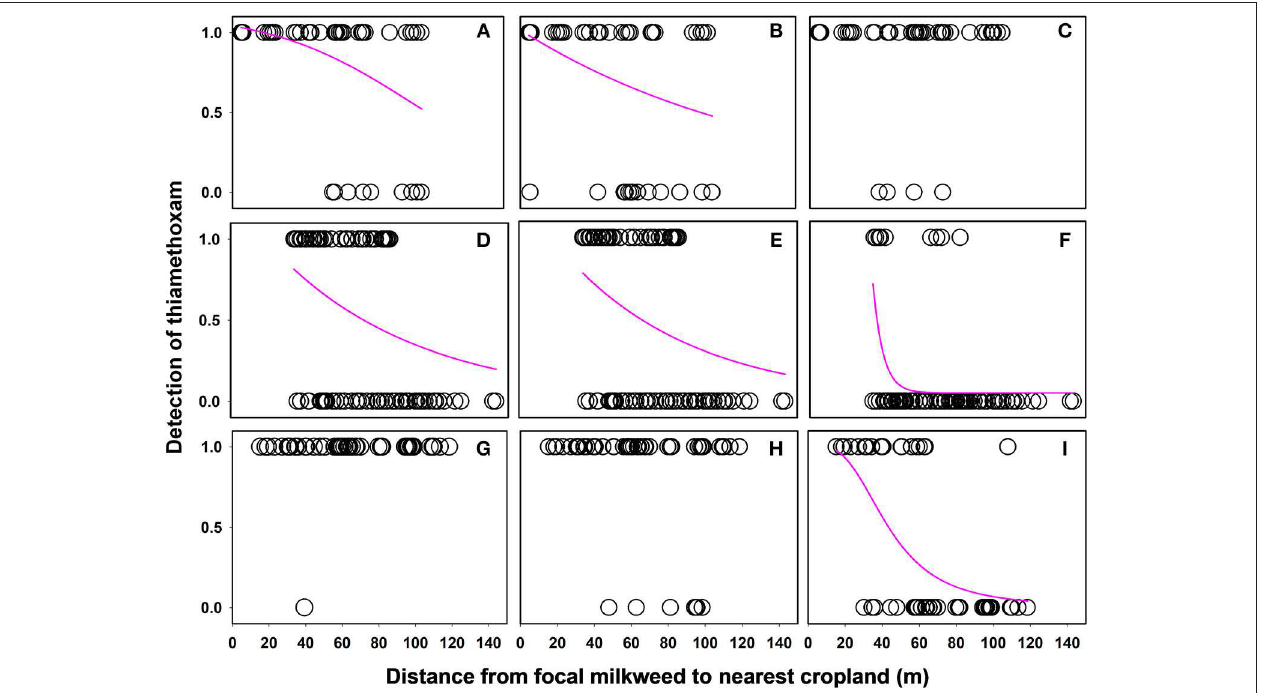
FIGURE 4 | Relationship between distance separating focal plants from cropland and detection of the neonicotinoid thiamethoxam associated with milkweed leaves. Each data point is an individual plant sample with “1” values = thiamethoxam detected and “0” values = thiamethoxam not detected. Best fit curves plotted to the data using sigmoidal or exponential decay functions. Data are for June, July, and August, respectively, for three sites in Indiana: ACRE (A–C) , PWA (D–F) , and Prophetstown (G–I)